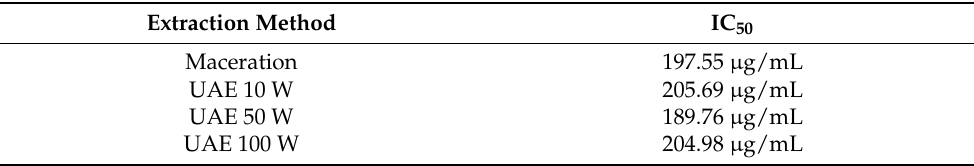
Table 2. IC 50 values of ethanolic extracts of pomegranate peels.